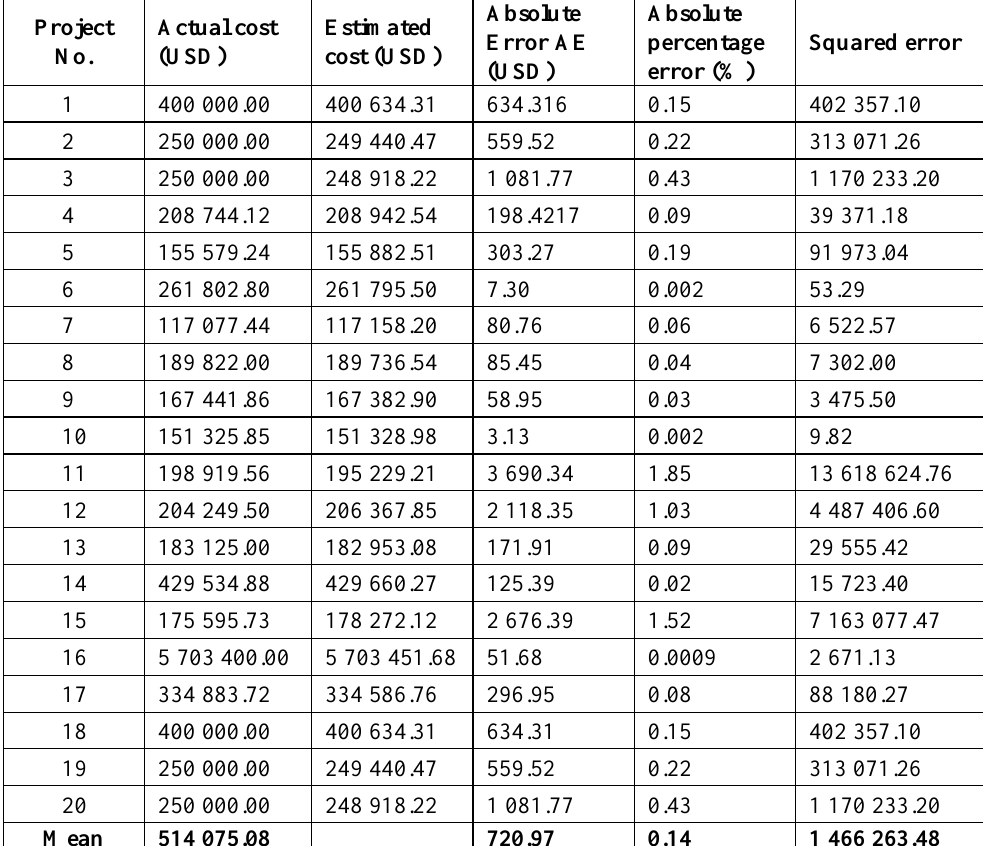
Table 5. Results of the testing process (developed by the author)